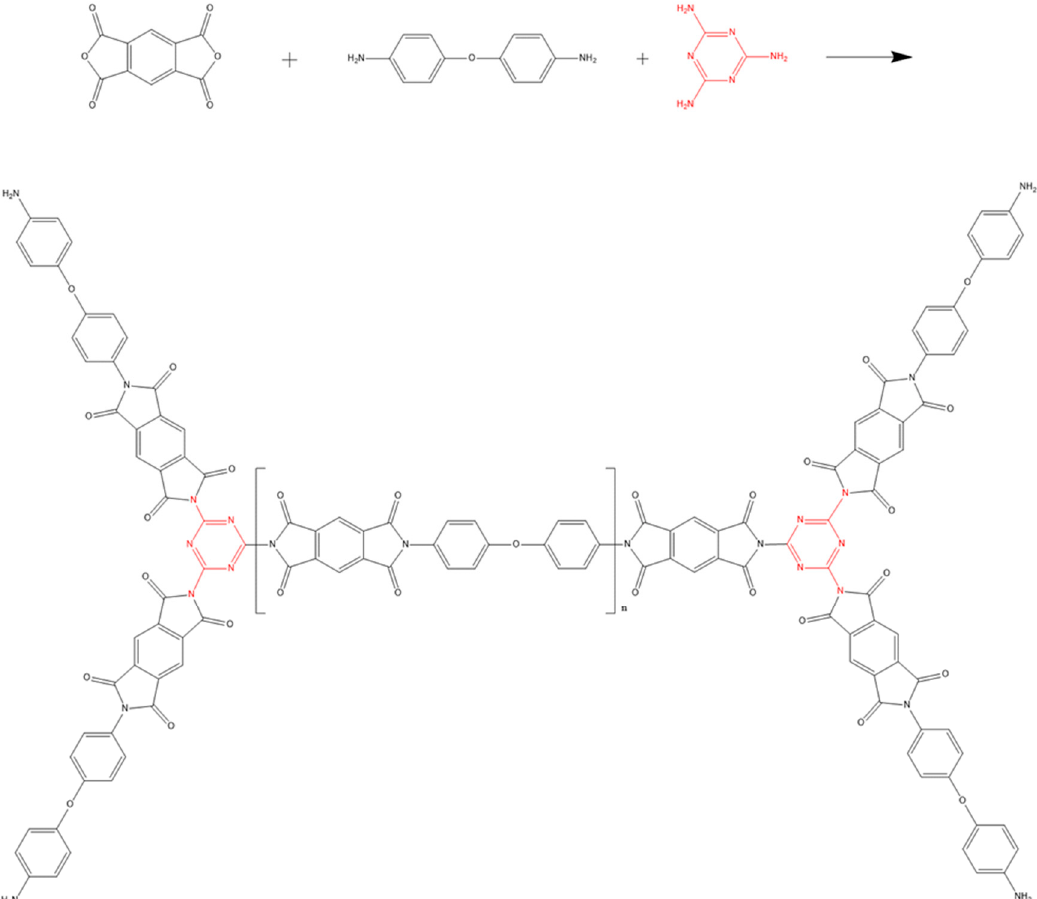
Figure 10. Scheme of the MPAA reaction.